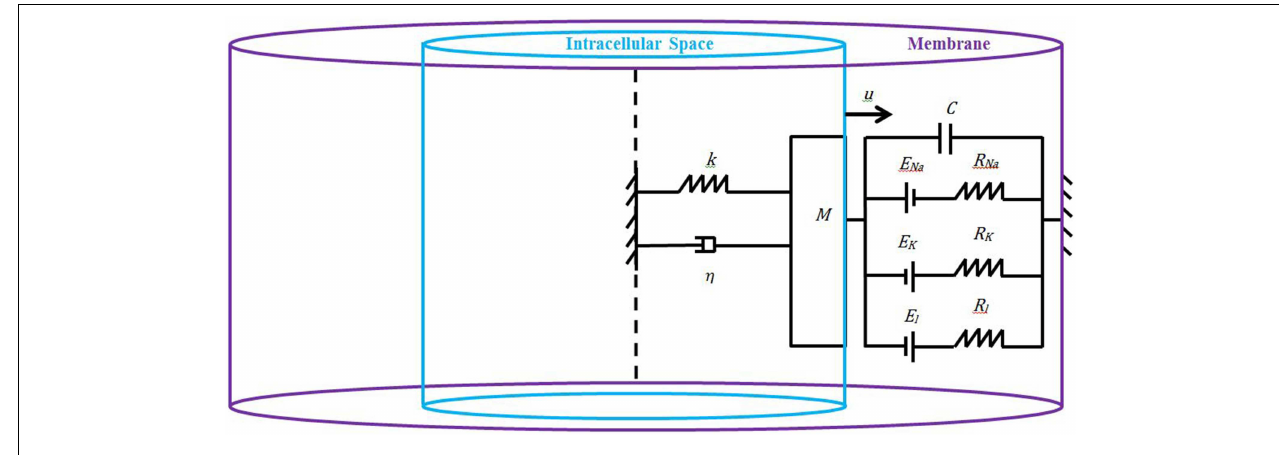
FIGURE 1 | Schematic of the proposed model: the neuron is an axi-symmetric homogeneous circular cylinder whose inner core is the intracellular space (light blue), and the outer layer is the membrane (purple). Due to the symmetry (dashpot line) and material homogeneity, it is